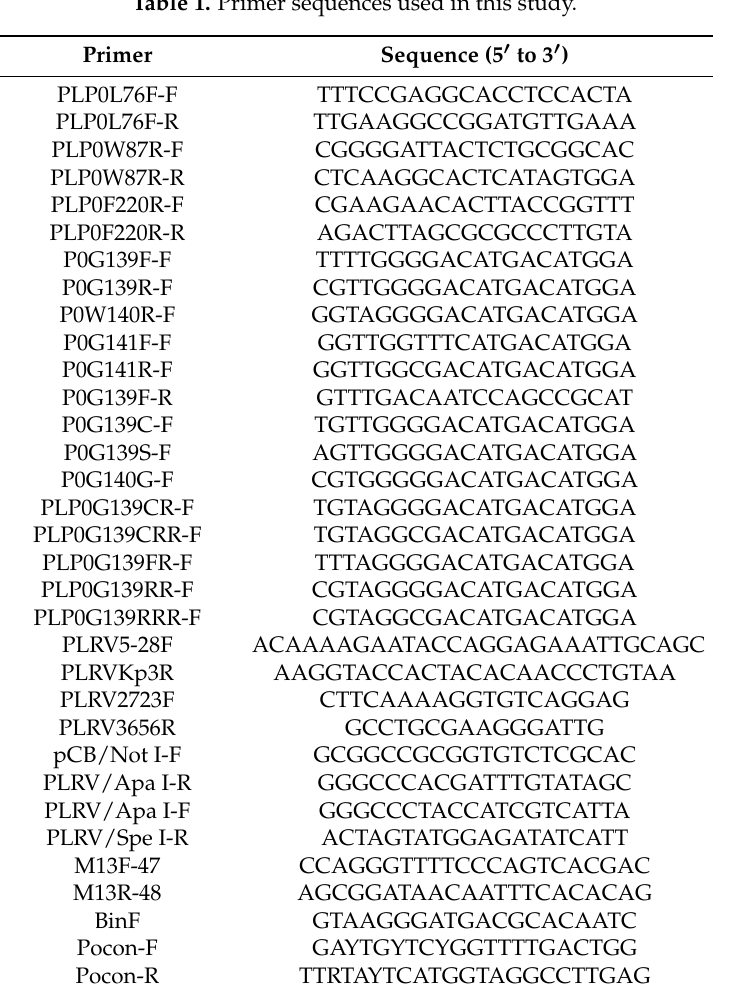
Table 1. Primer sequences used in this